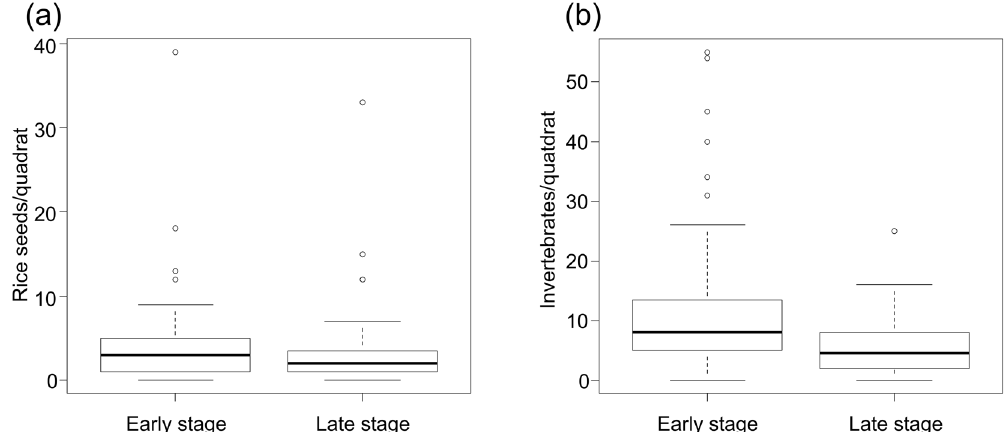
Figure 5. Box-and-whisker plots showing the abundance of potential food sources (rice seeds and benthic organisms) for shorebirds relative to time since habitat formation. The boxes represent the interquartile range for each food source, the horizontal line within the box is the median, and the whiskers show the range within the upper and lower limits. The circles represent outliers. The number of samples was 88 for the early stage (within 5 days of formation) and 80 for the late stage (after 10 days)